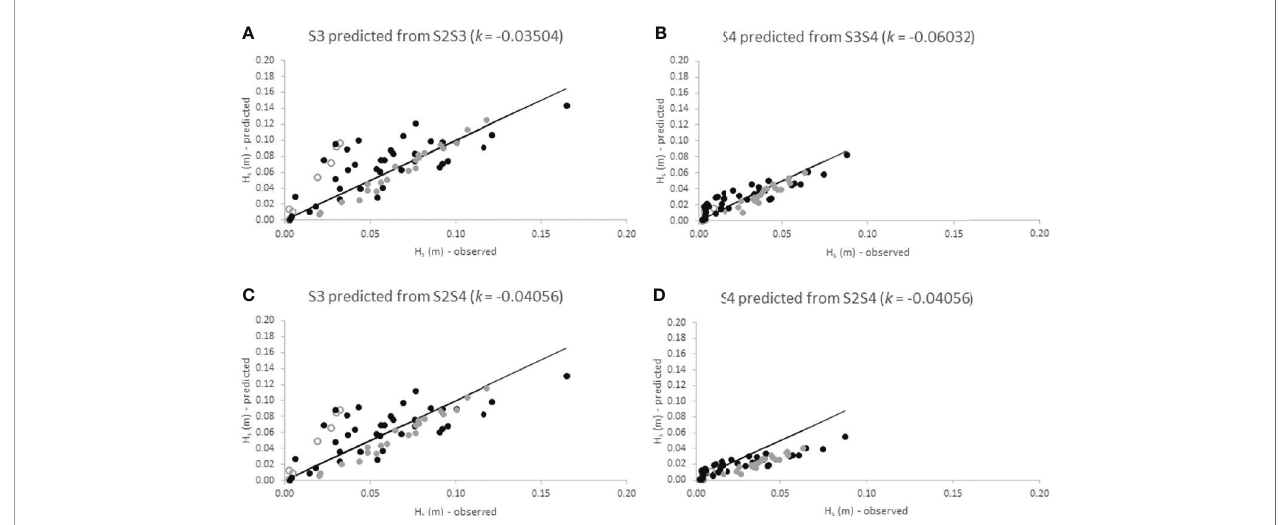
FIGURE 7 | Observed signi fi cant wave heights at the landward location of transect sections S2S3 (A) , S3S4 (B) and S2S4 (D) at Histria compared to wave heights calculated at those locations using the best- fi t dissipation coef fi cient ( k ) as derived from observed wave height dissipation over all seasons for those respective transect sections. Panel (C) shows wave heights predicted for the middle location (S3) on the basis of k derived from observed dissipation between S2 and S4. Data is shown per season (open circles = summer; black dots = winter; grey dots = spring). Black lines indicate lines of direct correspondence between observed and calculated wave heights.